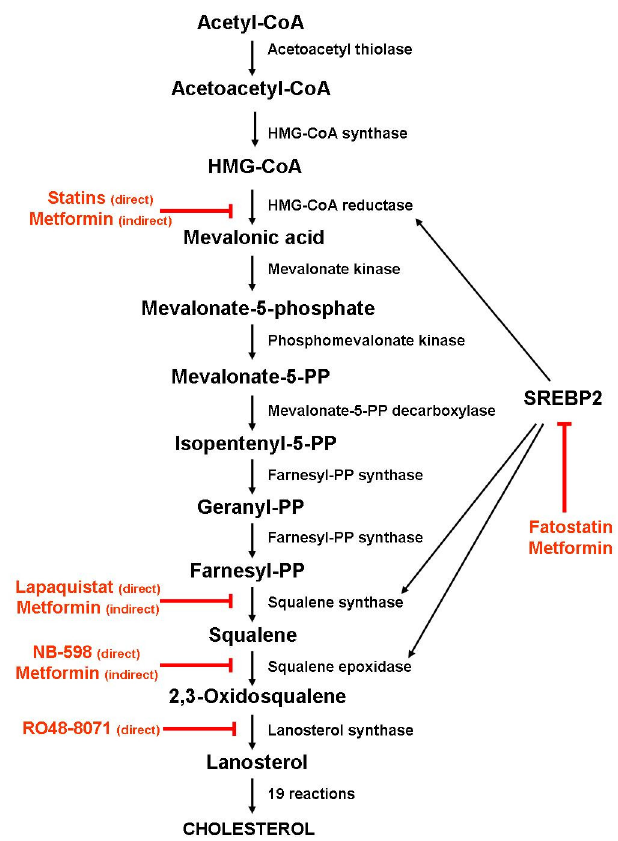
Figure 1 . Schematic diagram depicting the enzymes involved in the cholesterol biosynthesis and the steps inhibited by statins and metformin. Black arrow: activation; red arrow: